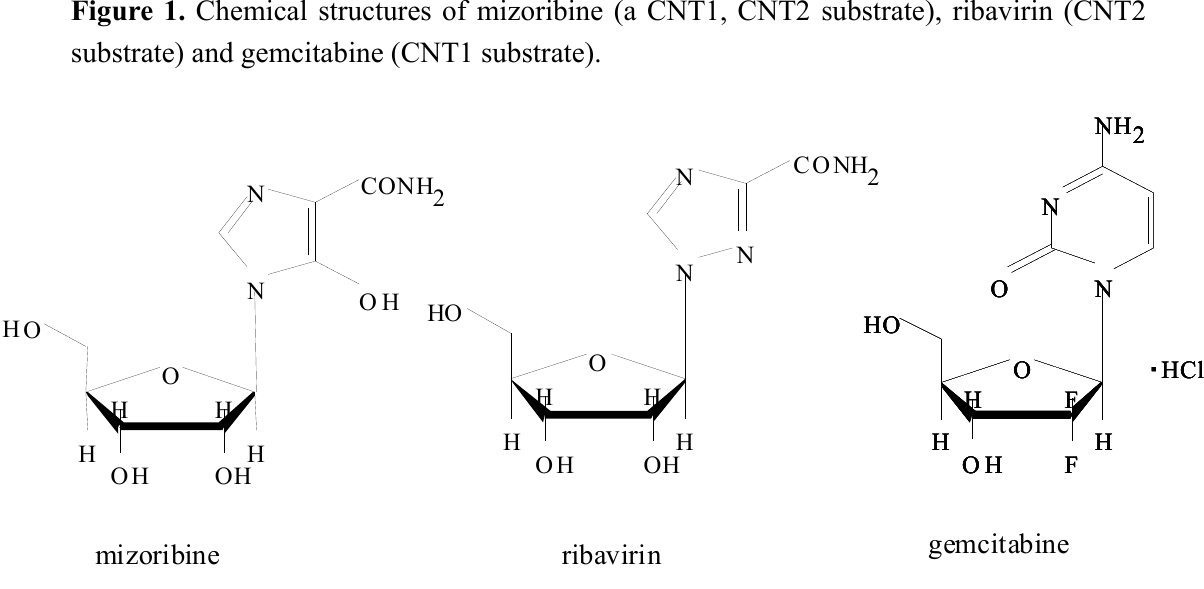
Figure 1. Chemical structures of mizoribine (a CNT1, CNT2 substrate), ribavirin (CNT2 substrate) and gemcitabine (CNT1